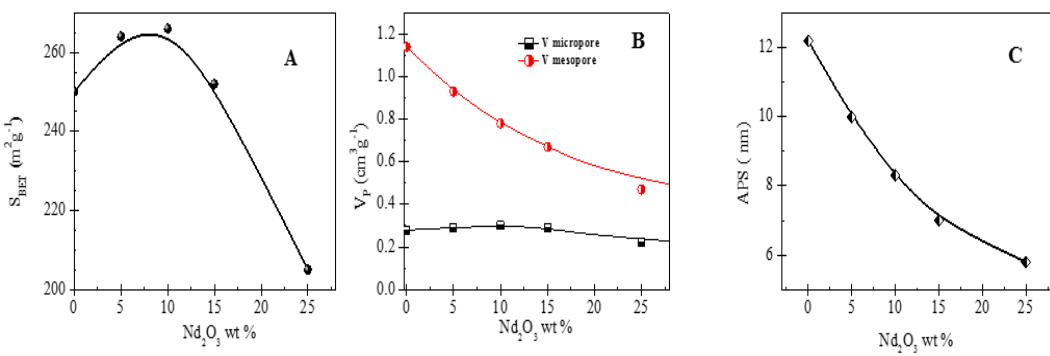
Figure 1. ( A ) BET specific surface area, ( B ) specific micropore and mesopore volume, and ( C ) average pore size of the Al-Nd- x binary oxides.